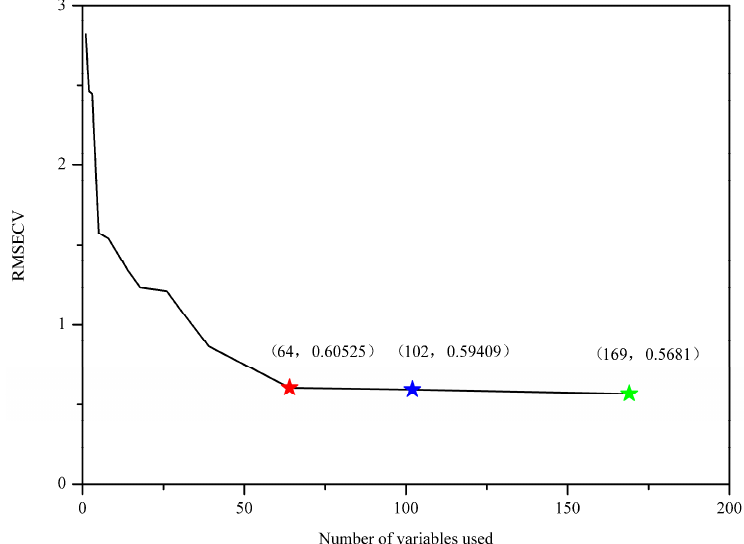
Figure 3. The root mean square error of cross-validation (RMSECV) of the number of variables included. The global, the better, and the suggested model are marked with green, blue, and red stars, respectively.